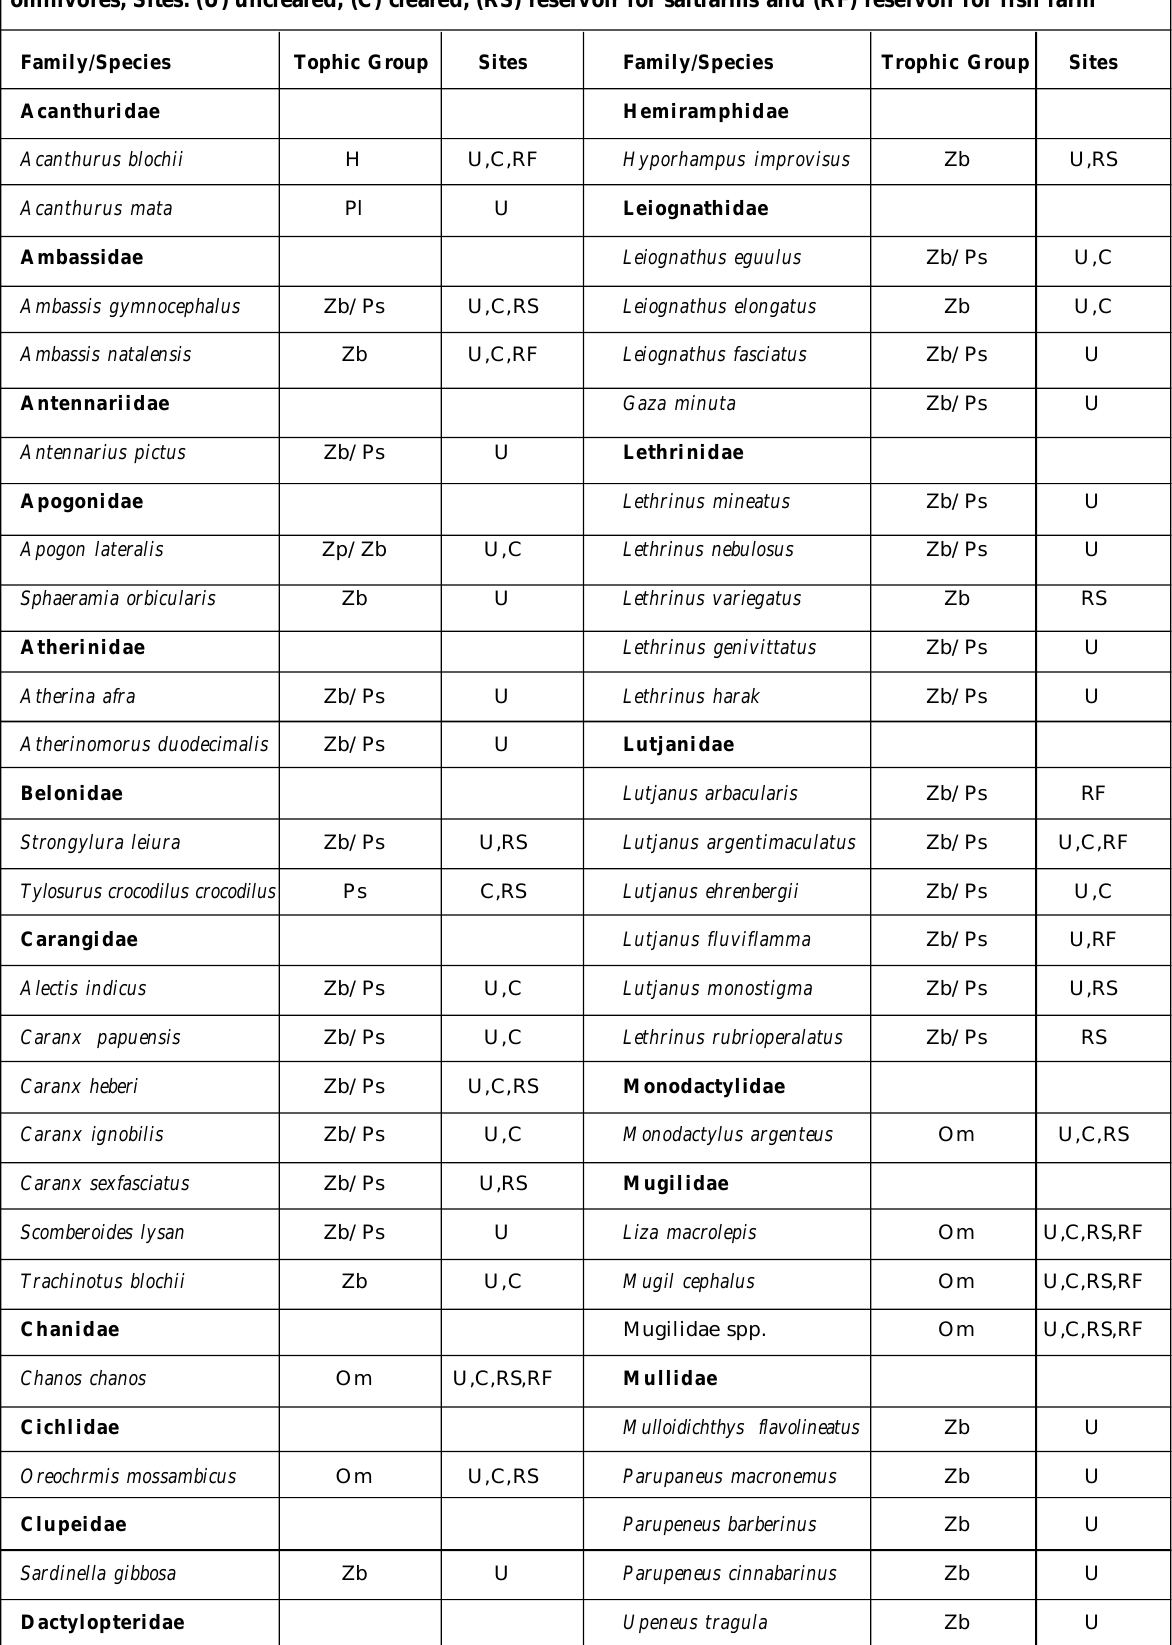
Table 2: Fish species from mangrove creeks along the coastline of Tanzania separated into trophic groups based on FishBase (Froese and Pauly, 2009) and field observations. Feeding